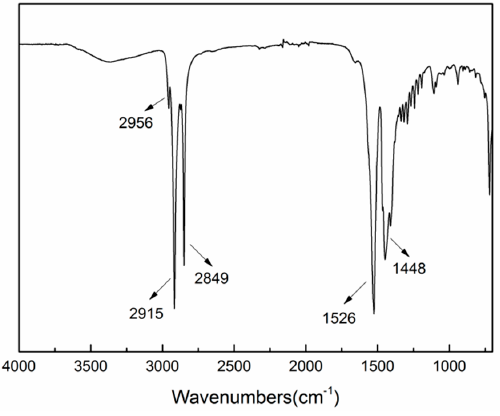
Figure 5. Fourier transform infrared spectrophotometer (FTIR) spectrum of the superhydrophobic surface obtained by pulse electrodeposition under 60% duty ratio.